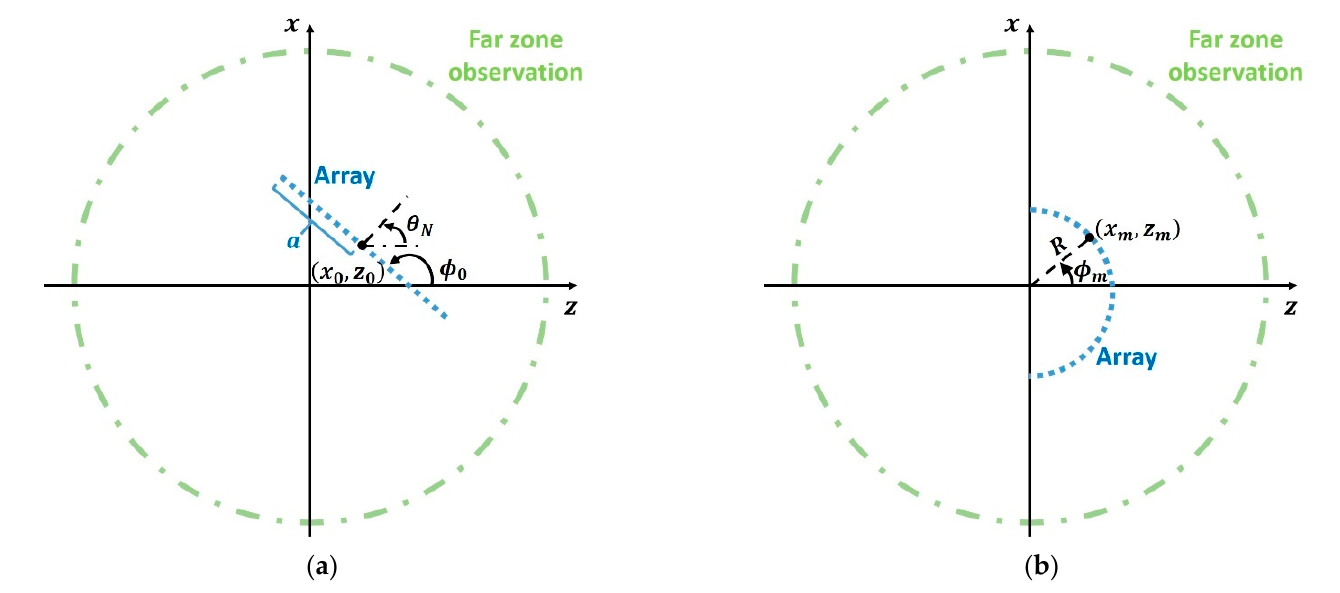
Figure 2. Parameters of a linear ( a ) and semi-circumference ( b ) array.